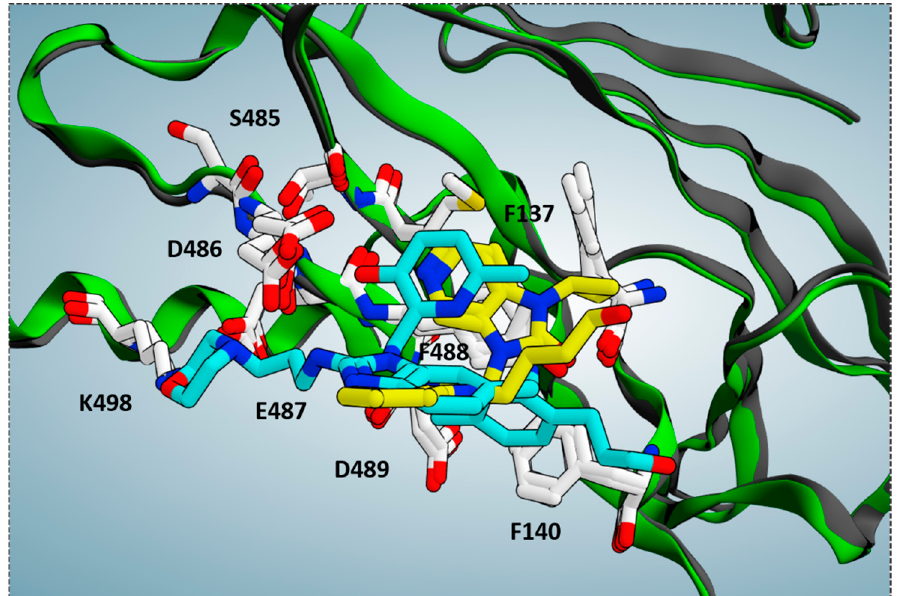
Figure 6. Superimposition of the X-ray complexes of the RSV F protein in presence of the two inhibitors TMC-353121 (C atom in cyan; pdb code = 5EA5) [13] and BMS-433771 (C atom in yellow; pdb code = 5EA7) [13].